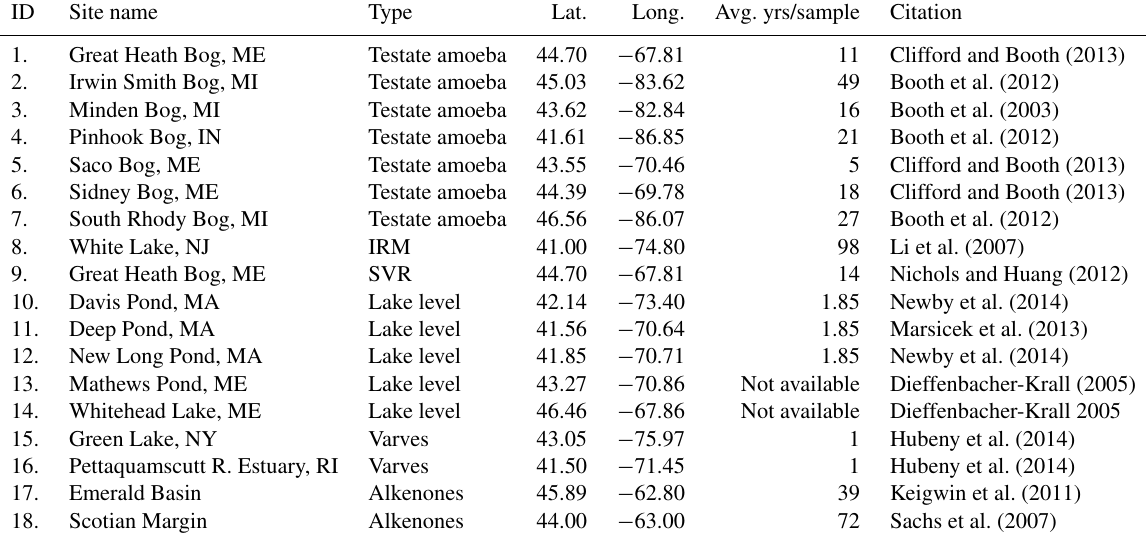
Table 1. Site ID, location, data type, sample resolution for the past 3000 years, and citations for sites used in this study. IRM is isothermal remanent magnetization and SVR is Sphagnum /vascular ratio. The sample resolution for New Long Pond could not be obtained as raw data were not provided for the study. Mathews Pond and Whitehead Lake are not provided because a continuous age model was not constructed and trends are therefore approximations